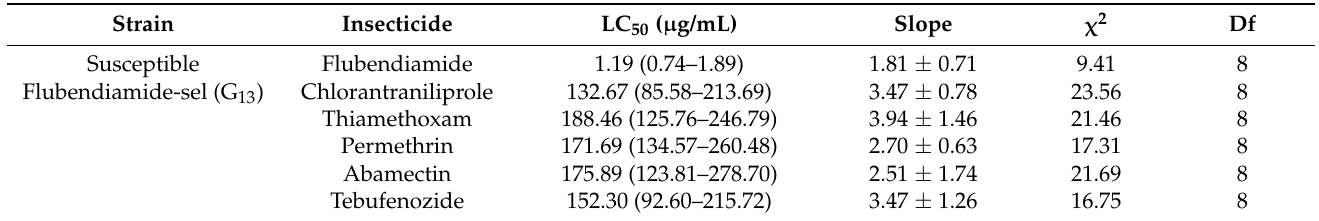
Table 8. Concentration mortality response of flubendiamide-sel (G 13 ) Tuta absoluta population to different